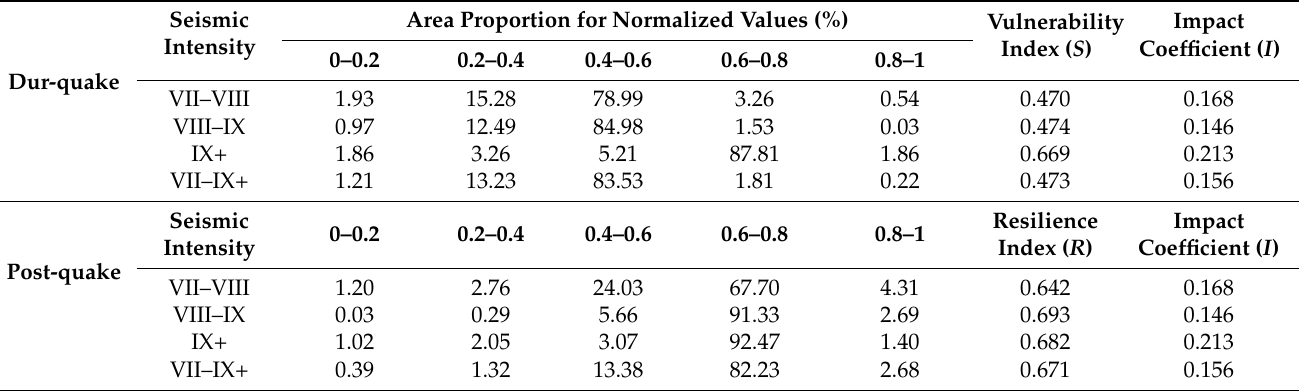
Table 3. The area proportion for ∆ NPP value normalization, vulnerability index ( S ) and resilience index ( R ) of 3 seismic intensities and the whole study region from July to August